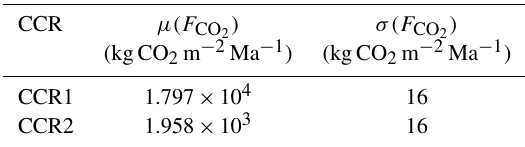
Table 4. Mean( µ ) and standard deviation ( σ ) computed for F CO computed for activation surfaces depicted in Fig.